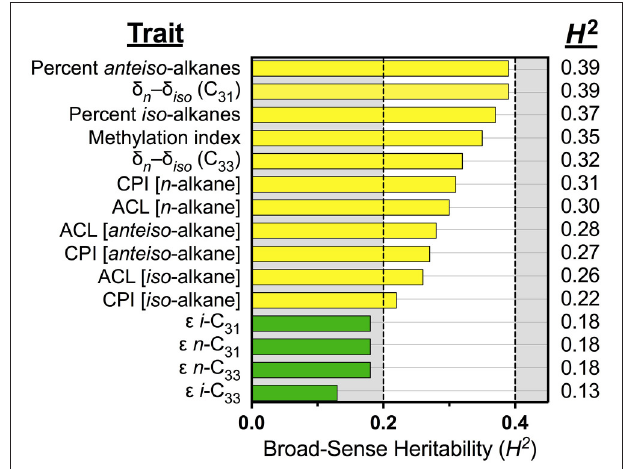
FIGURE 3 | Broad-sense heritability for leaf wax traits. Colors denote traits with intermediate (yellow, 0.2 ≤ H 2 < 0.4), and low (green, H 2 < 0.2) heritability values. All traits were measured from plants grown under greenhouse conditions in early 2014, St. Louis MO. The majority of leaf wax traits have intermediate heritability values. The apparent fractionations of individual alkanes ( ε values) have low heritability